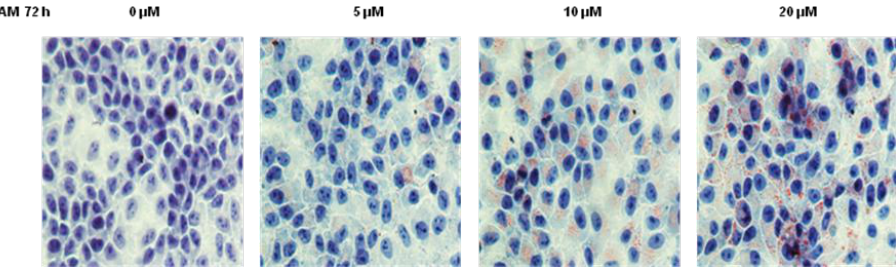
Figure 1. The effect of increasing concentrations of tamoxifen (TAM) on intracellular lipid accumulation in HepG2 (Human hepatocellular liver carcinoma cell line) cells stained with Oil Red O. Hepatocytes were incubated with 0, 5, 10 and 20 μM of TAM for 72 h, respectively, and then collected for Oil Red O staining. Representative images of Oil Red O stained cells treated with different concentrations of TAM are shown. Cells were examined under a light microscope at a magnification of 400×.